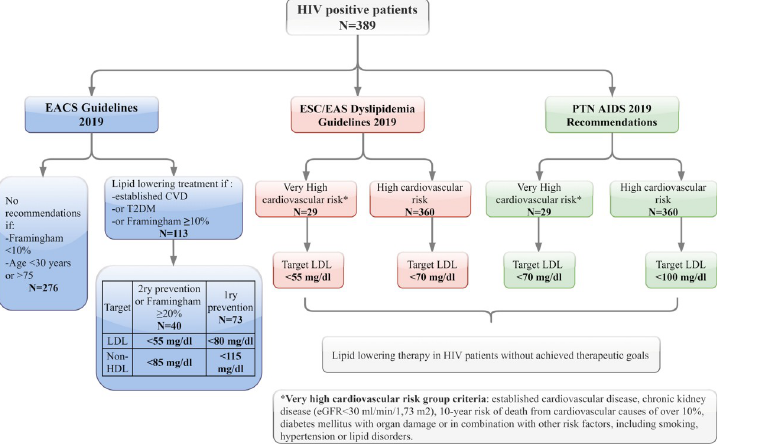
Fig 1. HIV patients according to different cardiovascular